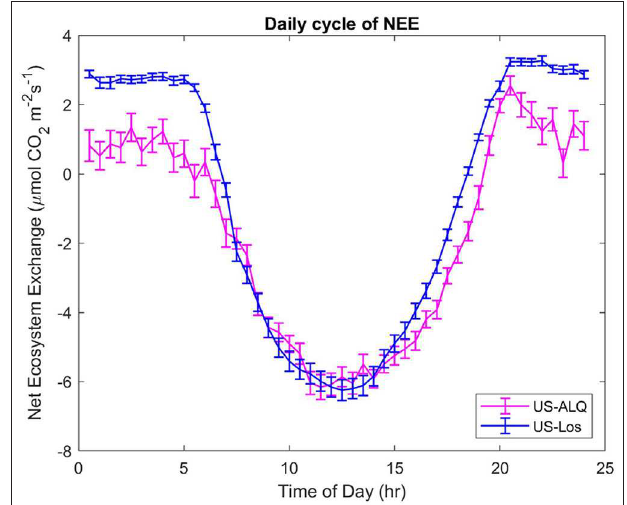
FIGURE 7 | Daily cycles of NEE for both sites. Half-hourly fluxes were averaged over the entire growing season. Error bars represent standard error of the mean. Pink, sheltered fen (US-ALQ); blue, open fen